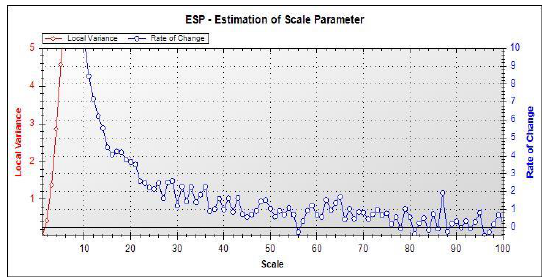
Figure 3 The curves of LV and ROC with the change of segmentation scale